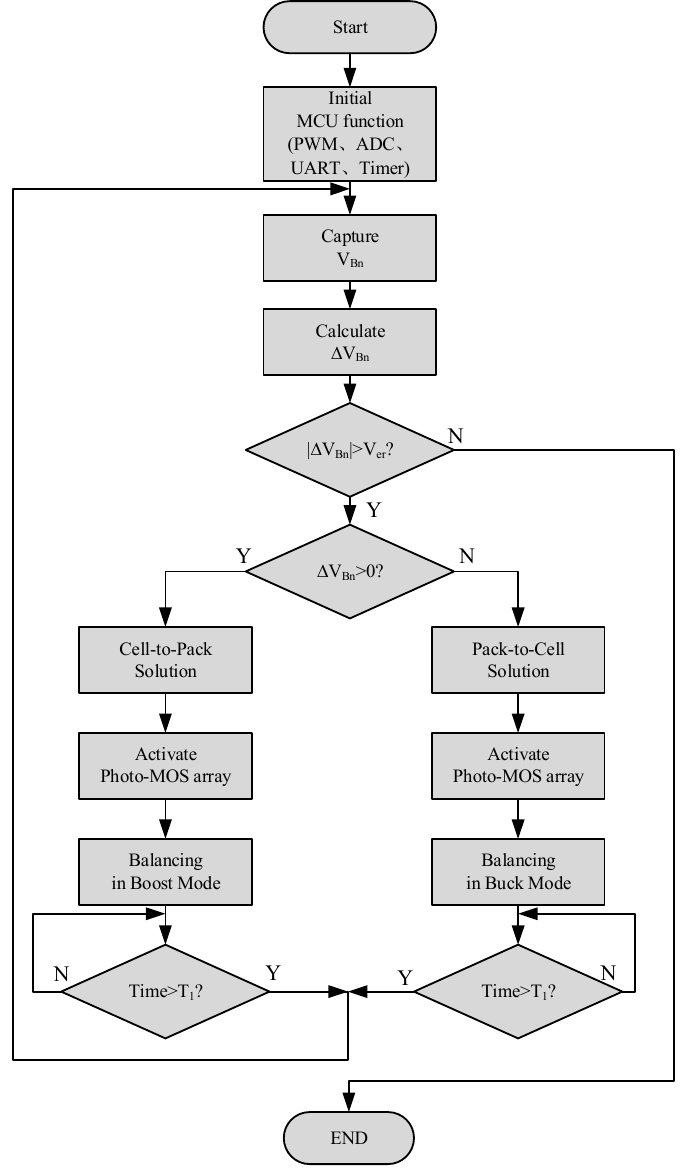
Figure 2. Power loss analysis of the cell balancing system.